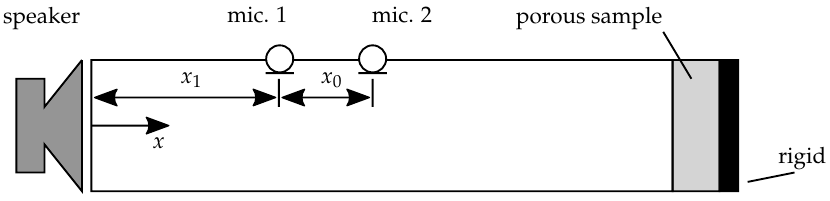
Figure 3. Measurement principle of the absorption coefficient